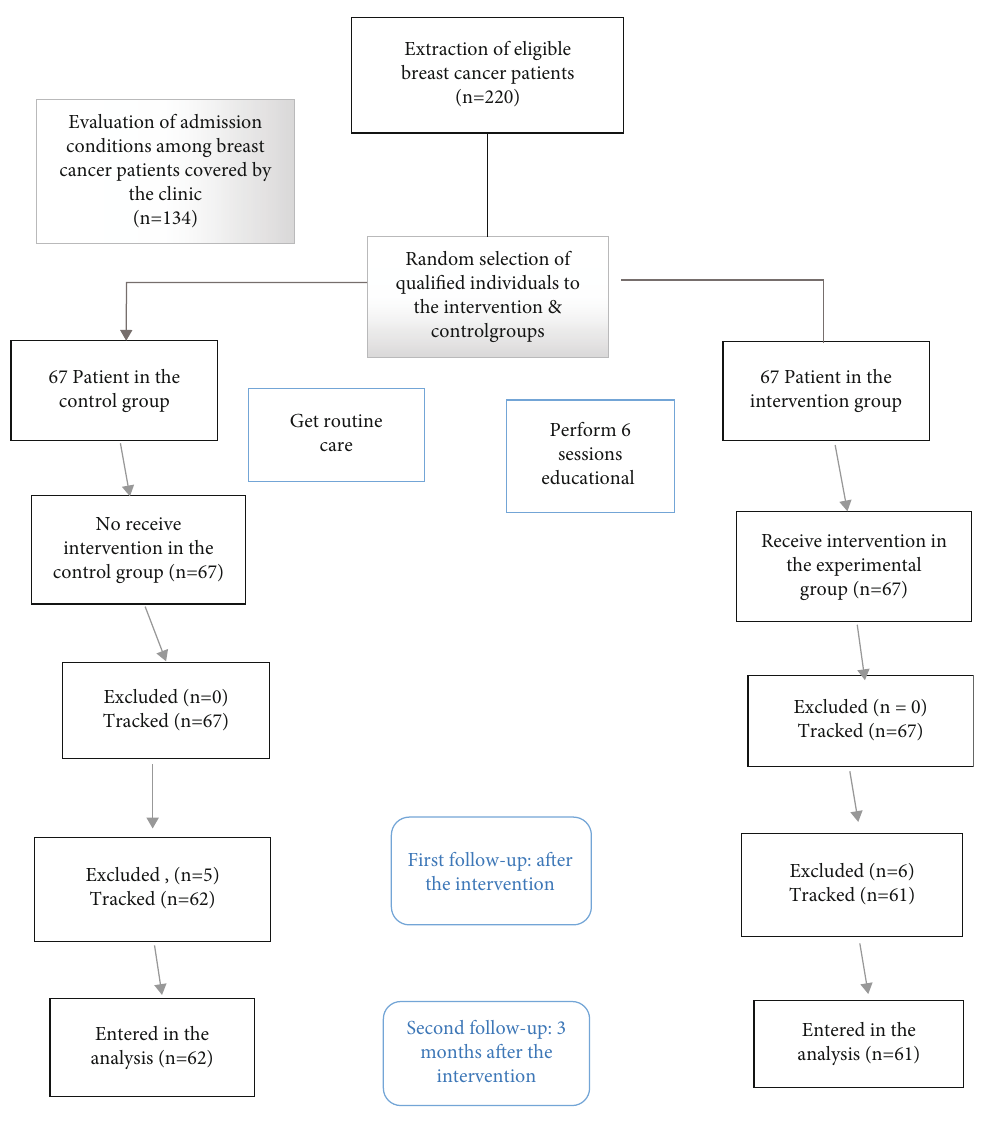
Figure 2: Study concert